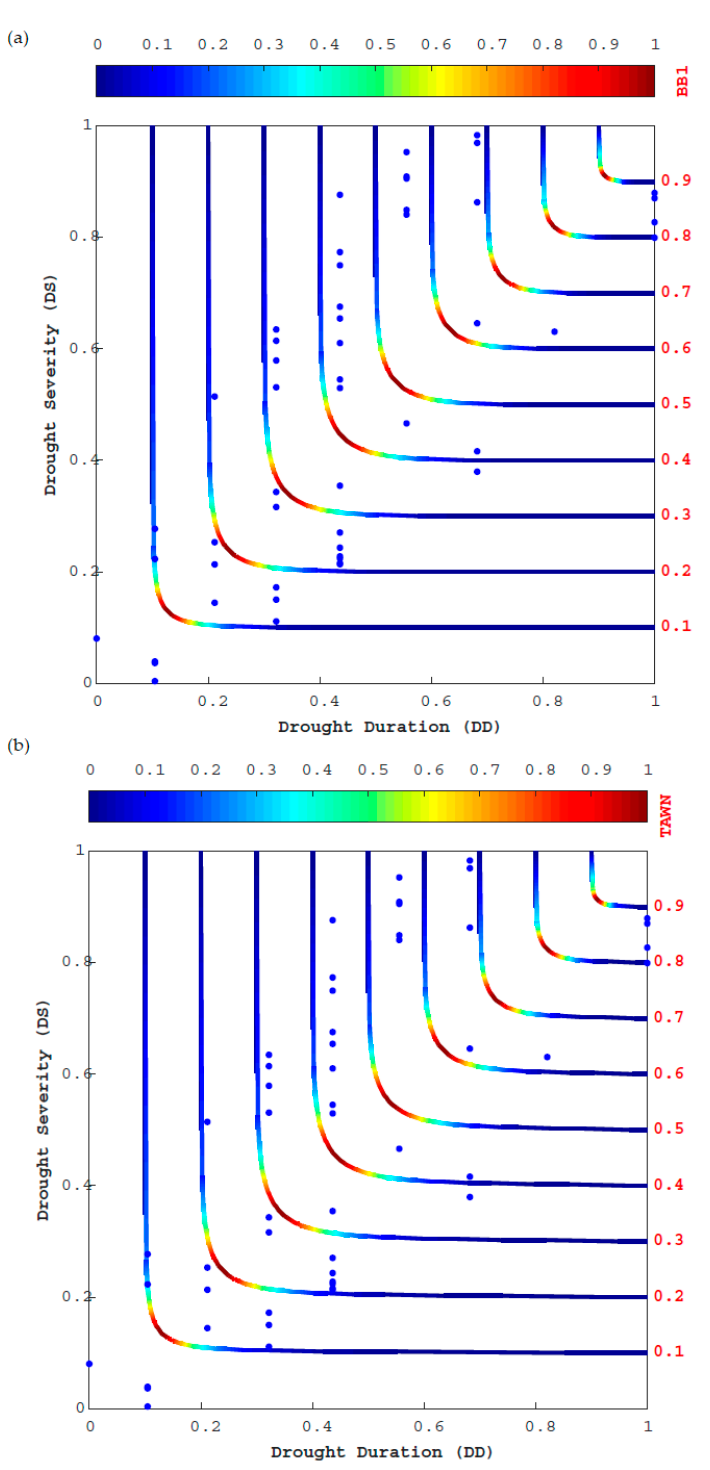
Figure 5. A typical dependence structure of drought duration and severity based on SPI-6 time series. In the figure ( a ) corresponds to BB1 and ( b ) corresponds to Tawn copulas.